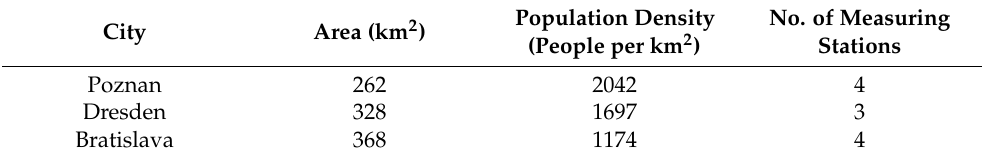
Table 1. Descriptive parameters of analyzed European cities, based on Refs.